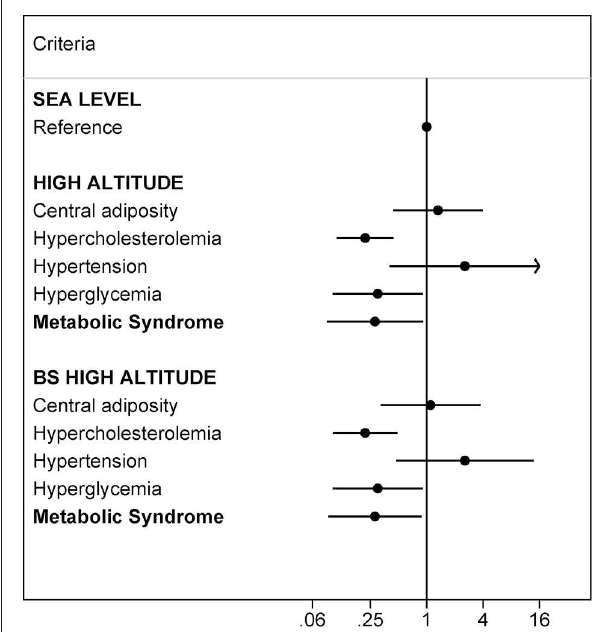
FIGURE 1 | Validity analysis . Risk of developing each component of MetS according to the altitude level assessed with logistic regression and bootstrapped (BS) logistic regression (1,000 random samples). MetS harmonizing definition (IDF-AHA/NHLBI). Multivariate Model 1 adjusted for: age, sex, self-reported energy intake and residence time. Ref. category of reference.